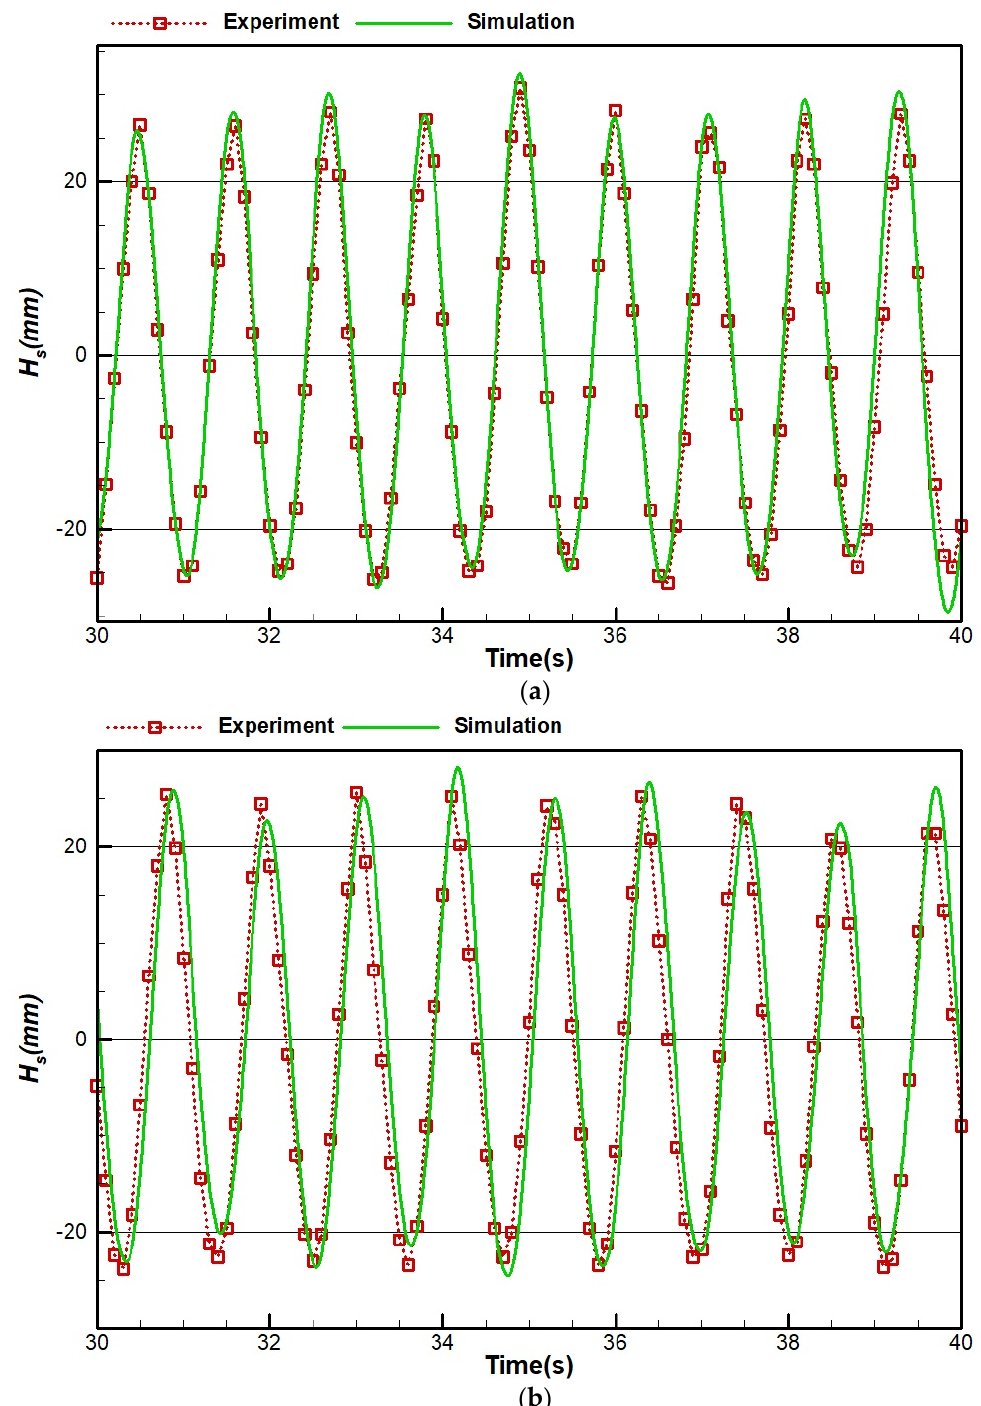
Figure 20. Wave height of case 3 at distances of ( a ) 3 m and ( b ) 5 m from the flap.